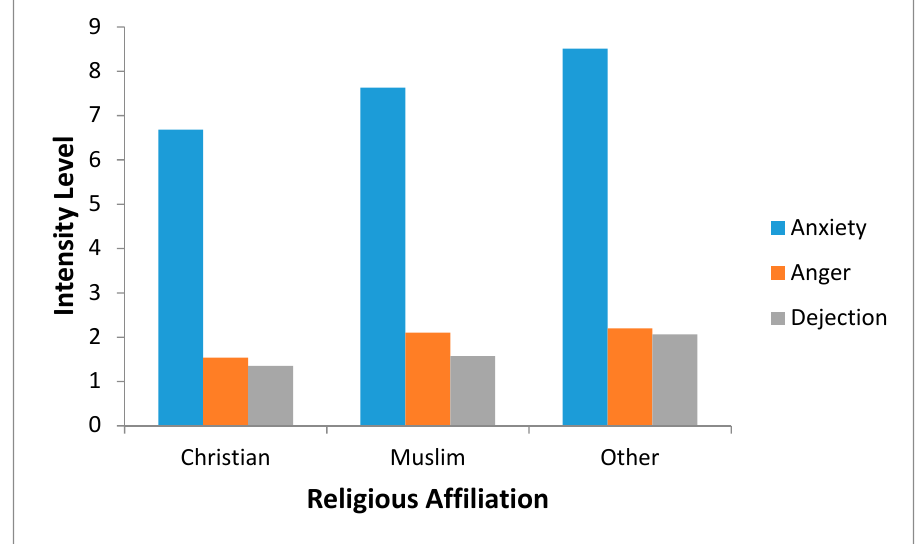
Figure 2. Student-athletes’ reported negative emotions across religious affiliation.